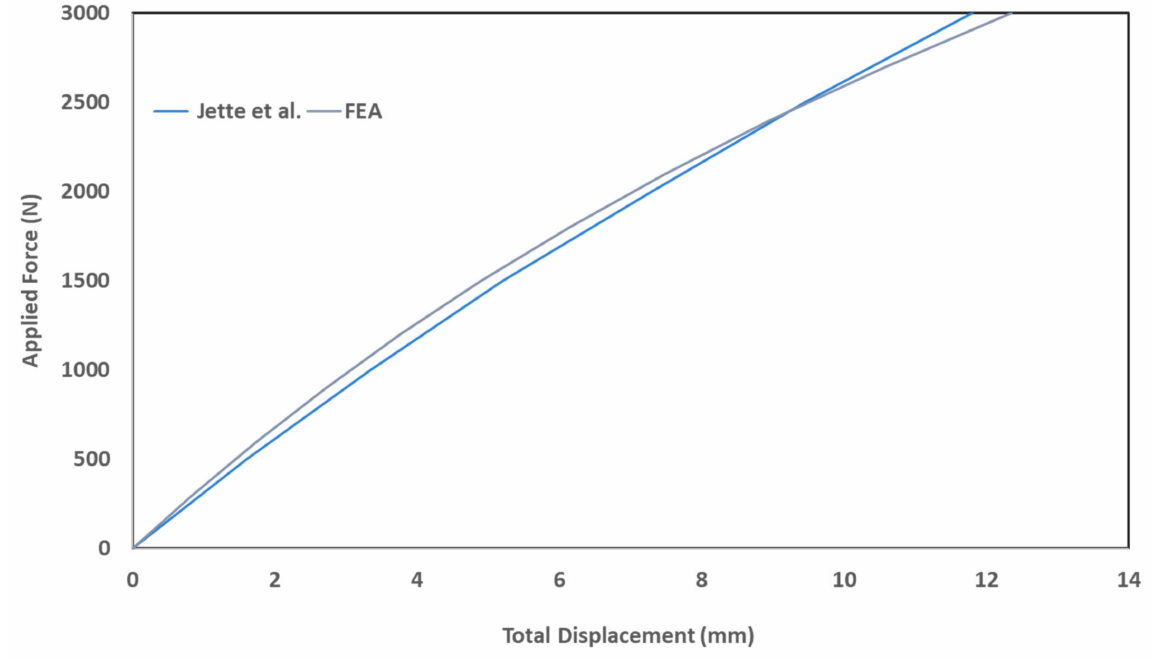
Figure 6. Stem-bone model validation of bulk stem against Jett el. al. FE results